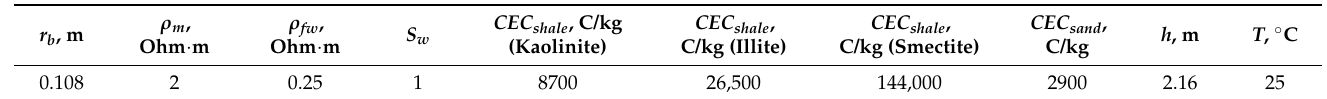
Table 2. Parameters used in numerical simulation of SP logging curve, taking into account claystone reservoir.